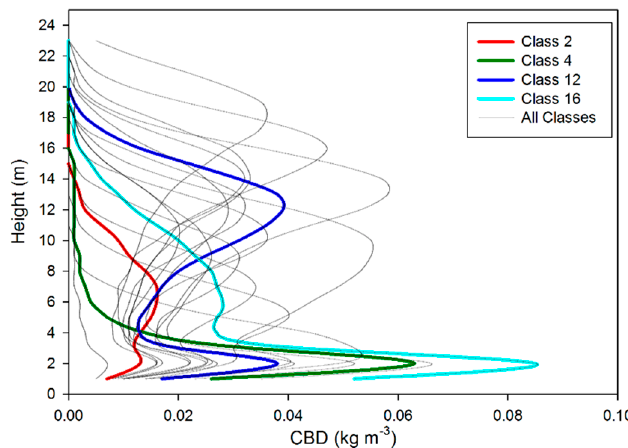
Figure 2. Unsupervised classification results. These are the average profiles of the 20 classes that resulted from the unsupervised classification of the CHP data. Note that Classes 2, 4, and 16 are negatively correlated with fire severity, while Class 12 is positively correlated.